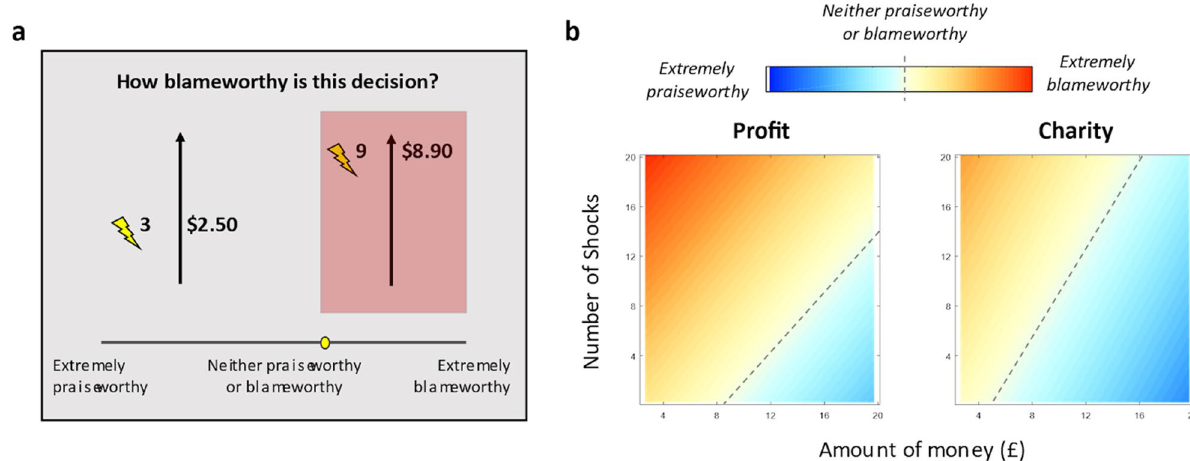
Figure 3. Moral judgment task and destination effects on blame. ( a ) In Study 2 participants rated how blameworthy they thought it would be if a person chose the more harmful option (i.e., the larger amount of money and shocks, highlighted in red) on a continuous scale ranging from 0 (extremely praiseworthy) to 100 (extremely blameworthy). ( b ) Estimated blame judgments from a linear mixed-effects model as a function of money and shocks. Blame for accepting dirty money is sensitive to the destination of the money. Dashed diagonal lines indicate mix of money and shocks that are neither praiseworthy nor